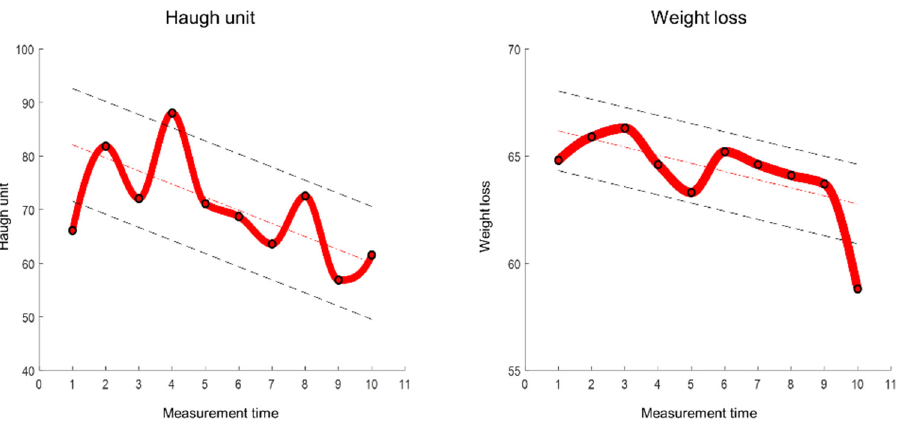
Figure 6. Interpolation of HU and weight loss of egg during real-time cold chain temperature con- dition.